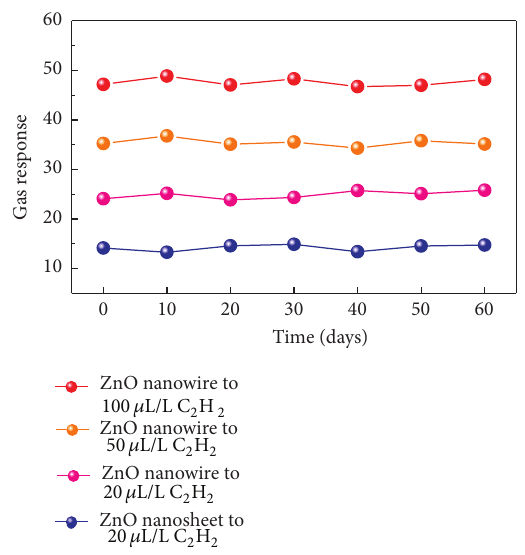
Figure 8: Stability and repeatability of the sensors to 20, 50, and 100 𝜇 L/L of C 2 H 2 at 550